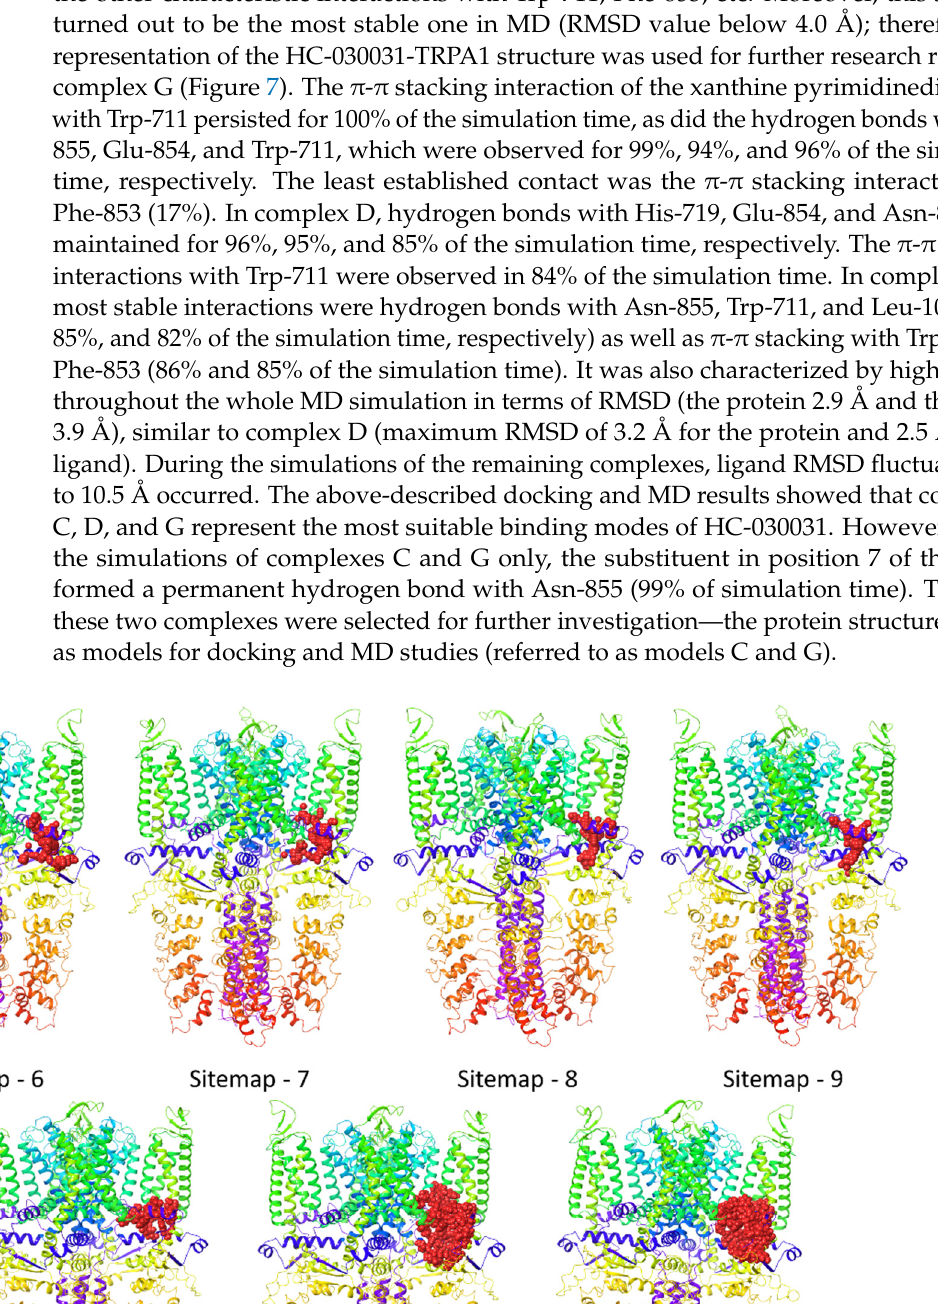
Table 6. Summary of HC-030031 induced-fit docking (IFD) results to individual binding sites: IFDScore and Docking score.